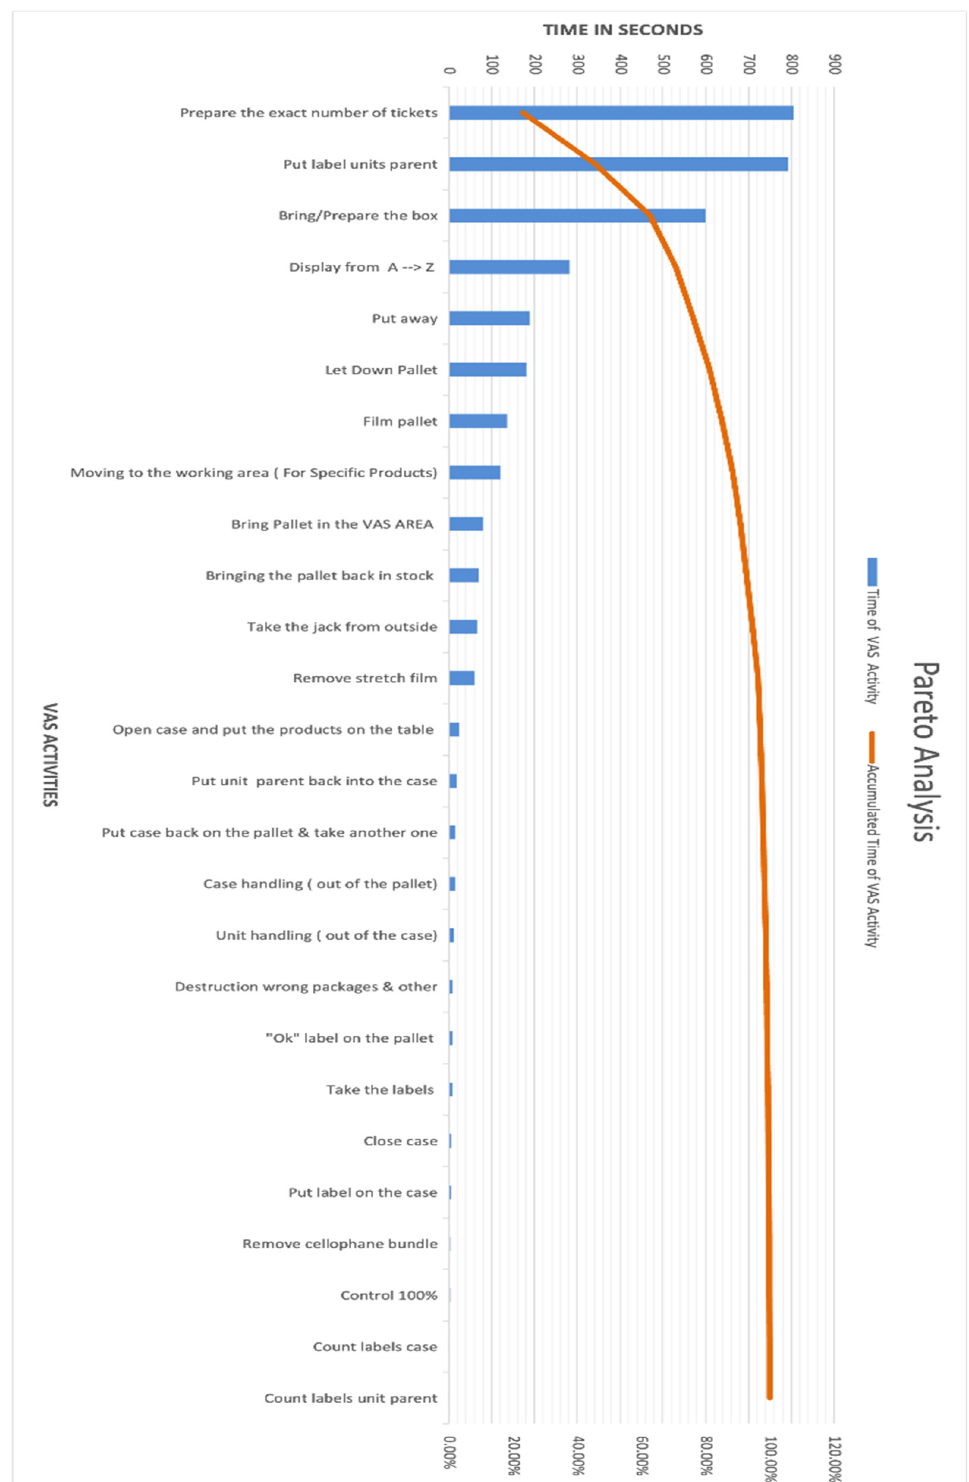
Figure 5. Pareto analysis for ophthalmic antihistamines and decongestants—display.